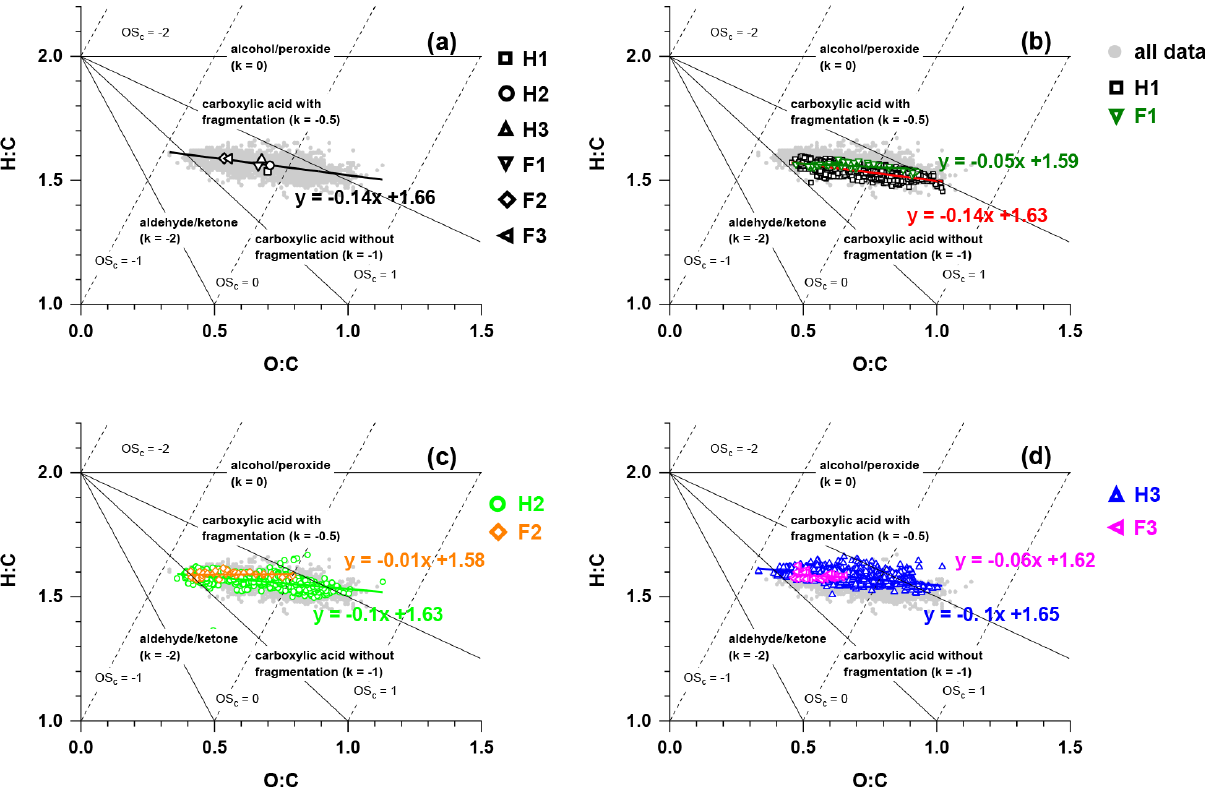
Figure 8. The van Krevelen–OS c diagram with data during (a) the whole campaign, (b) H1 and F1, (c) H2 and F2, and (d) H3 and F3. The triangle lines with different slopes show distinct formation processes (Heald et al.,